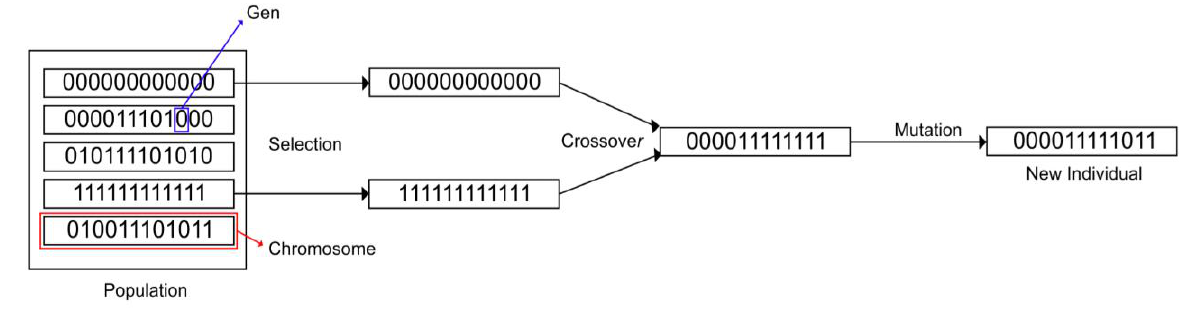
Figure 1. GA process